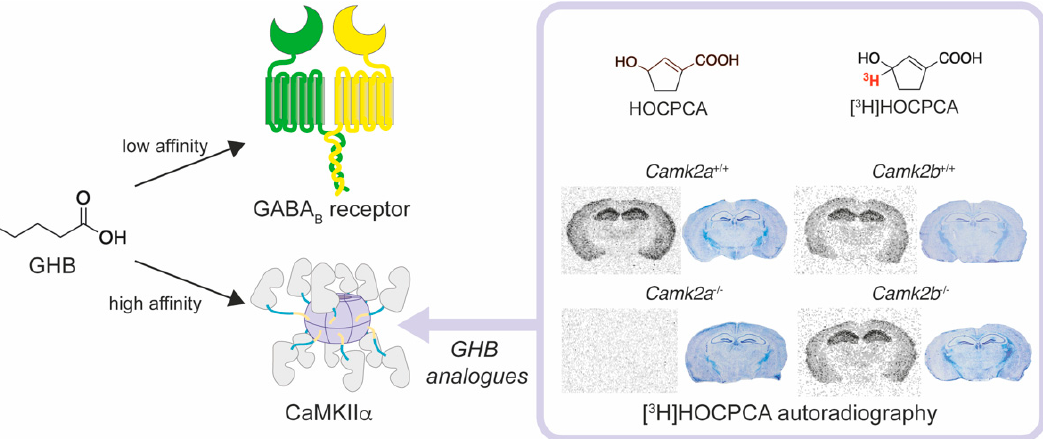
Figure 5. CaMKII α as high-affinity binding site for γ -hydroxybutyrate (GHB) [25,148]. GHB targets both high- and low-affinity binding sites within the CNS. One well-established low-affinity binding site is the GABA B receptor, and the high-affinity binding site was recently identified as CaMKII α . GHB analogues display improved affinity and selectivity for CaMKII α compared to GHB. E.g., the GHB analogue 3-hydroxycyclopent-1-enecarboxylic acid (HOCPCA) does not target GABA B receptors and its selectivity was studied by showing the complete absence of [ 3 H]HOCPCA binding to tissue from Camk2a − / − mice. In contrast, binding to Camk2a +/+ , Camk2b − / − and Camk2b +/+ mouse brain tissue was preserved.